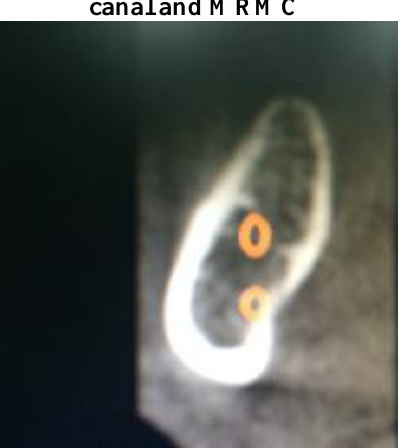
Fig. 4: CBCT coronal view show the inferior canal and MRMC